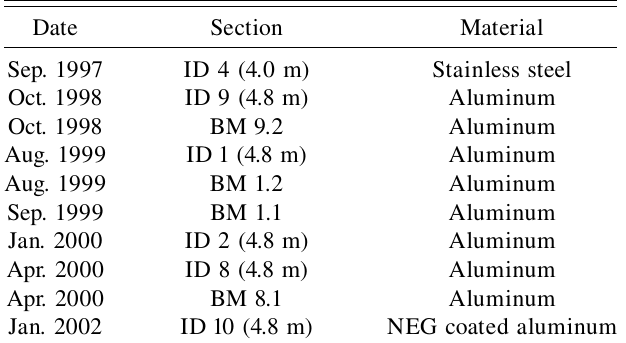
TABLE II. Dates of the installations of low gap straight sections (ID) and bending magnet (BM)